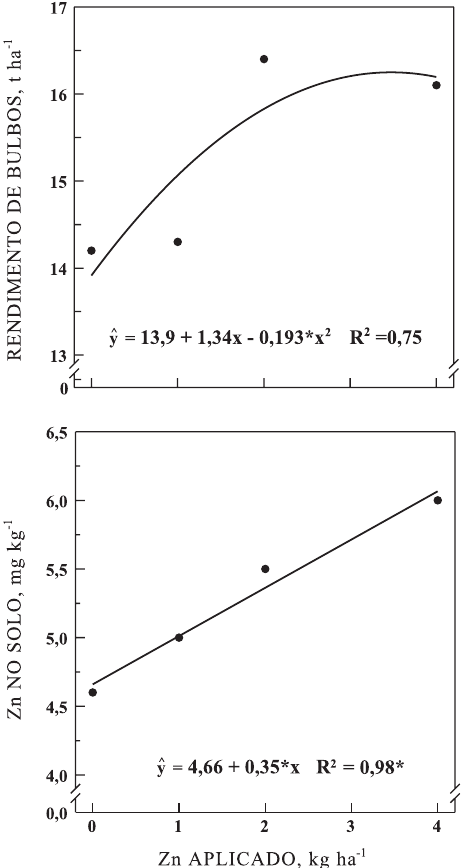
Figura 2. Produtividade de bulbos de cebola e teor de Zn no solo na safra 2007/2008, em função da adição de doses crescentes de Zn ao solo antes do plantio da safra 2006/2007. Média de quatro repetições. * Significativo (p < 5 %).